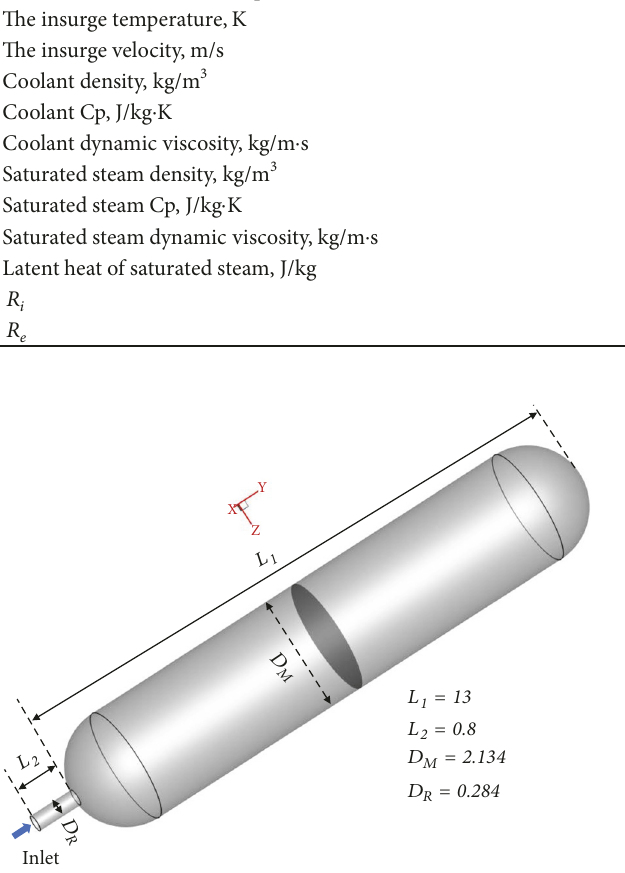
Figure 2: Geometry of the